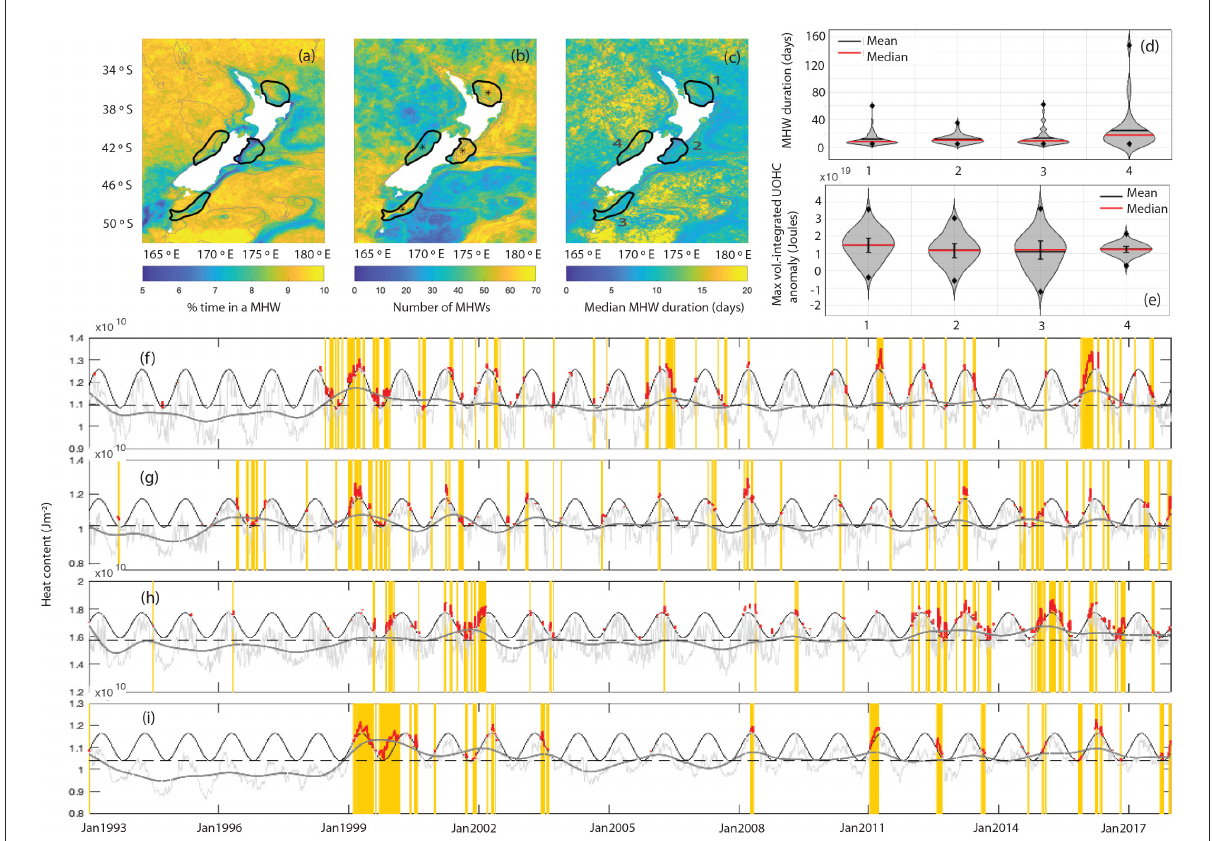
FIGURE3 Characterization of MHWs based on UOHC (a–c) . Regions for adjoint sensitivity analysis metrics are shown by the black lines: 1. Bay of Plenty, 2. Kaikoura, 3. Stewart Plateau and Snares Shelf 4. Hokitika. Violin plots showing distribution of MHW duration (d) and MHW magnitude (e) . Minimum and maximum values are shown by the black diamonds and on (e) error bars showing one standard deviation either side of the median are shown in black. UOHC above the 90th percentile thermocline at central point inside regions 1–4 (f–i) (gray line) and the 90th percentile daily climatological UOHC computed with an 11-day window (black line). The red lines indicate where the UOHC exceeds the 90th percentile daily climatology and the orange regions represent MHW events based on the definition of Hobday et al. (2016), using UOHC rather than SST (that is when the red lines have duration of 5 or more days). The dark gray line shows the heat content low-passed filtered at inter-annual